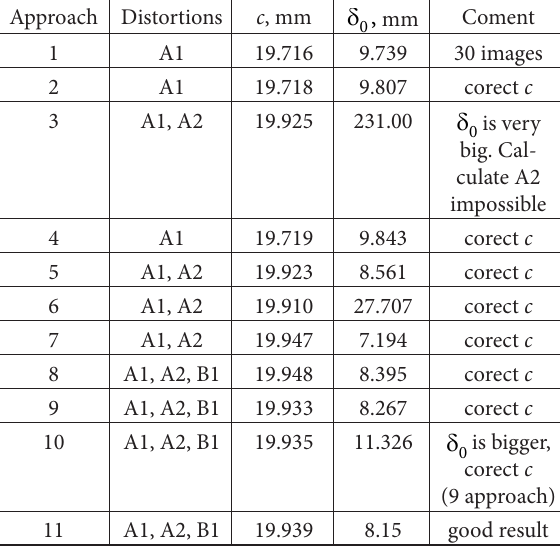
Table 1. Results of Canon EOS 1D Mark II calibration